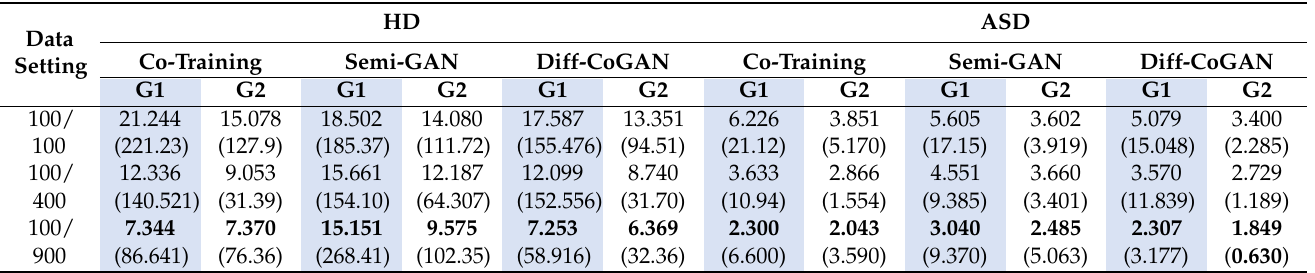
Table 9. The HD and ASD values for Spleen. The lowest HD value achieved by Diff-CoGAN shows that it produces more accurate boundary segmentation compared to semi-GAN and